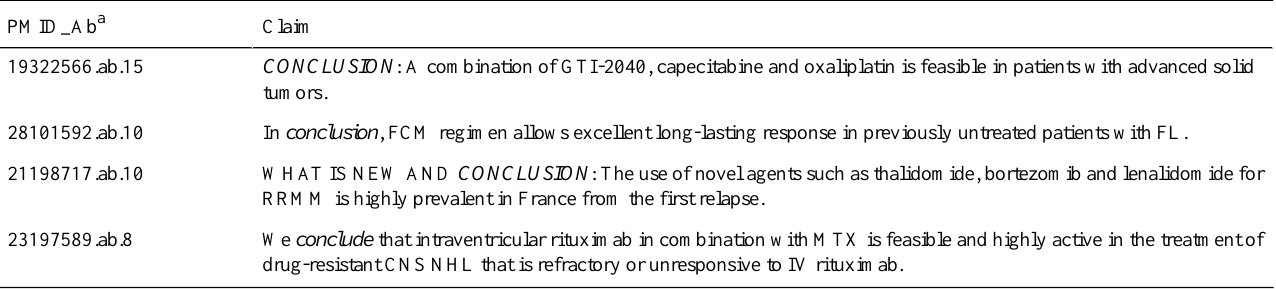
Table 1. Examples of conclusive claims from PubMed